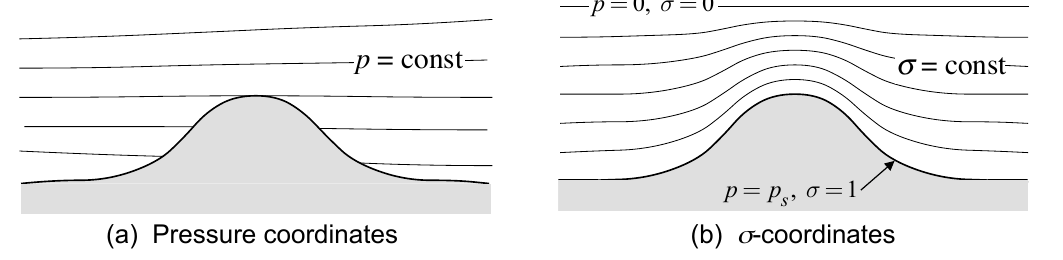
Figure 11. Vertical sections showing: ( a ) pressure coordinates; and ( b ) sigma